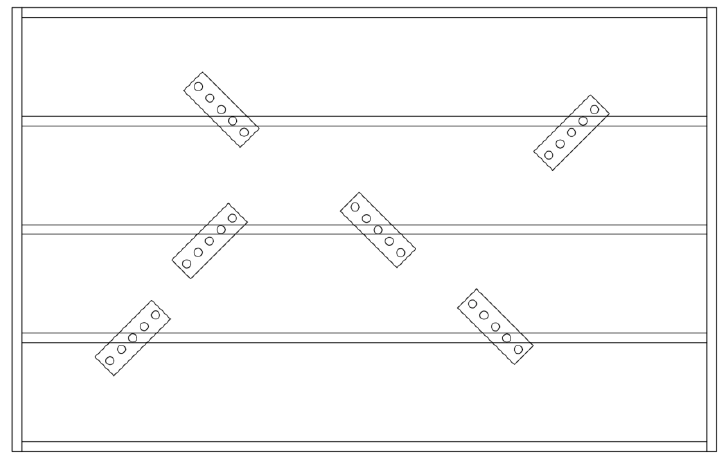
Figure 1. Example locations of a tapping machine on a lightweight reference floor.